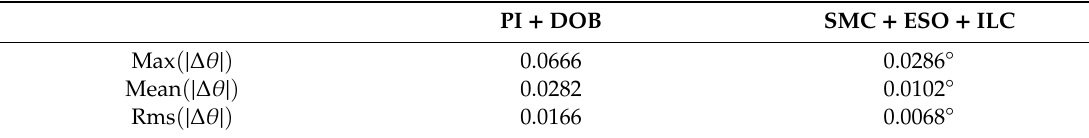
Table 5. Position pointing error of uniform speed tracking.